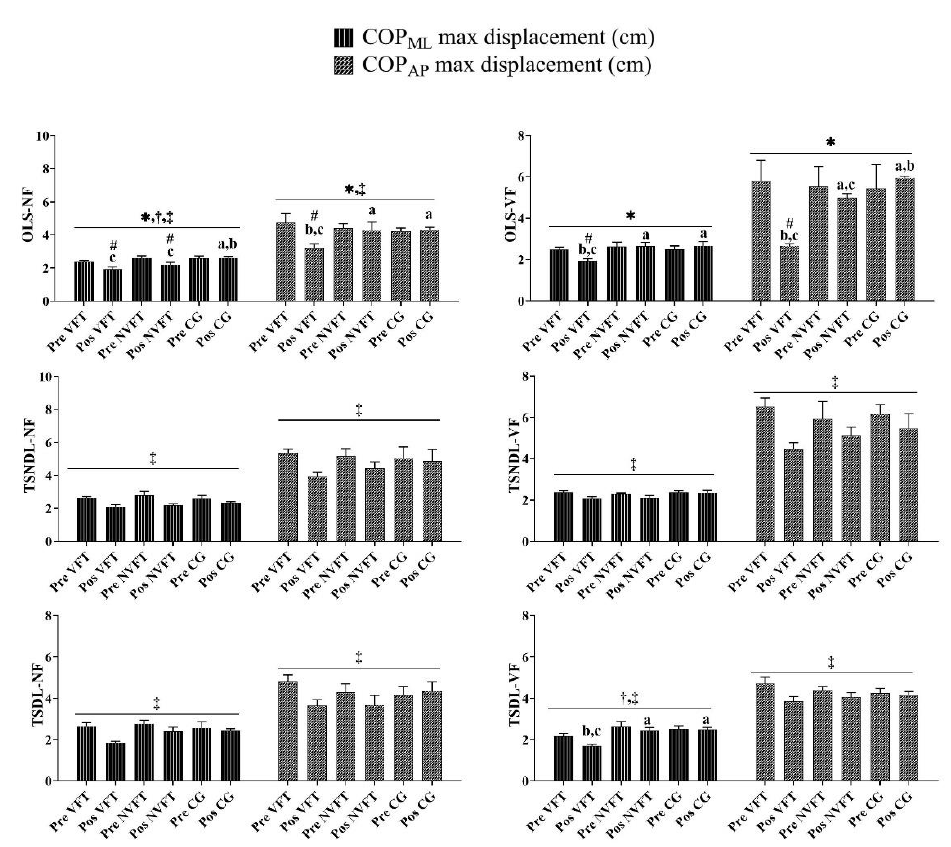
Figure 2. The training of group and time differences in the COP ML and COP AP maximum displacement parameters. Note: * Indicates a significant difference in interaction (Group*Times) ( p < 0.05). † Indicates a significant difference in main effect (group) ( p < 0.05). ‡ Indicates a significant difference in main effect (times) ( p < 0.05). # Indicates a significant difference with pre-test. a Indicates a significant difference with VFT. b Indicates a significant difference with NVFT. c Indicates a significant difference with CG. VFT and NVFT before and after the test of various parameters of COP in OLS/TS. There was a significant difference in the interaction (Group*Times) of the COP ML max displacement or COP AP max displacement in OLS ( p < 0.05). There was no significant difference in the interaction (Group*Times) of the COP ML max displacement or COP AP max displacement in TS ( p > 0.05).